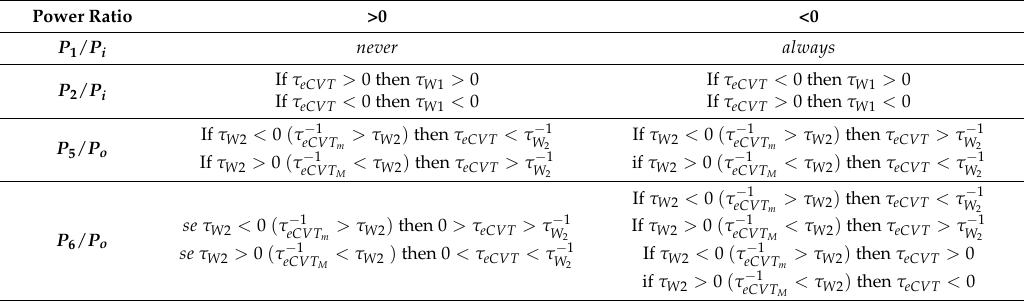
Table 8. Case 4—Power ratios